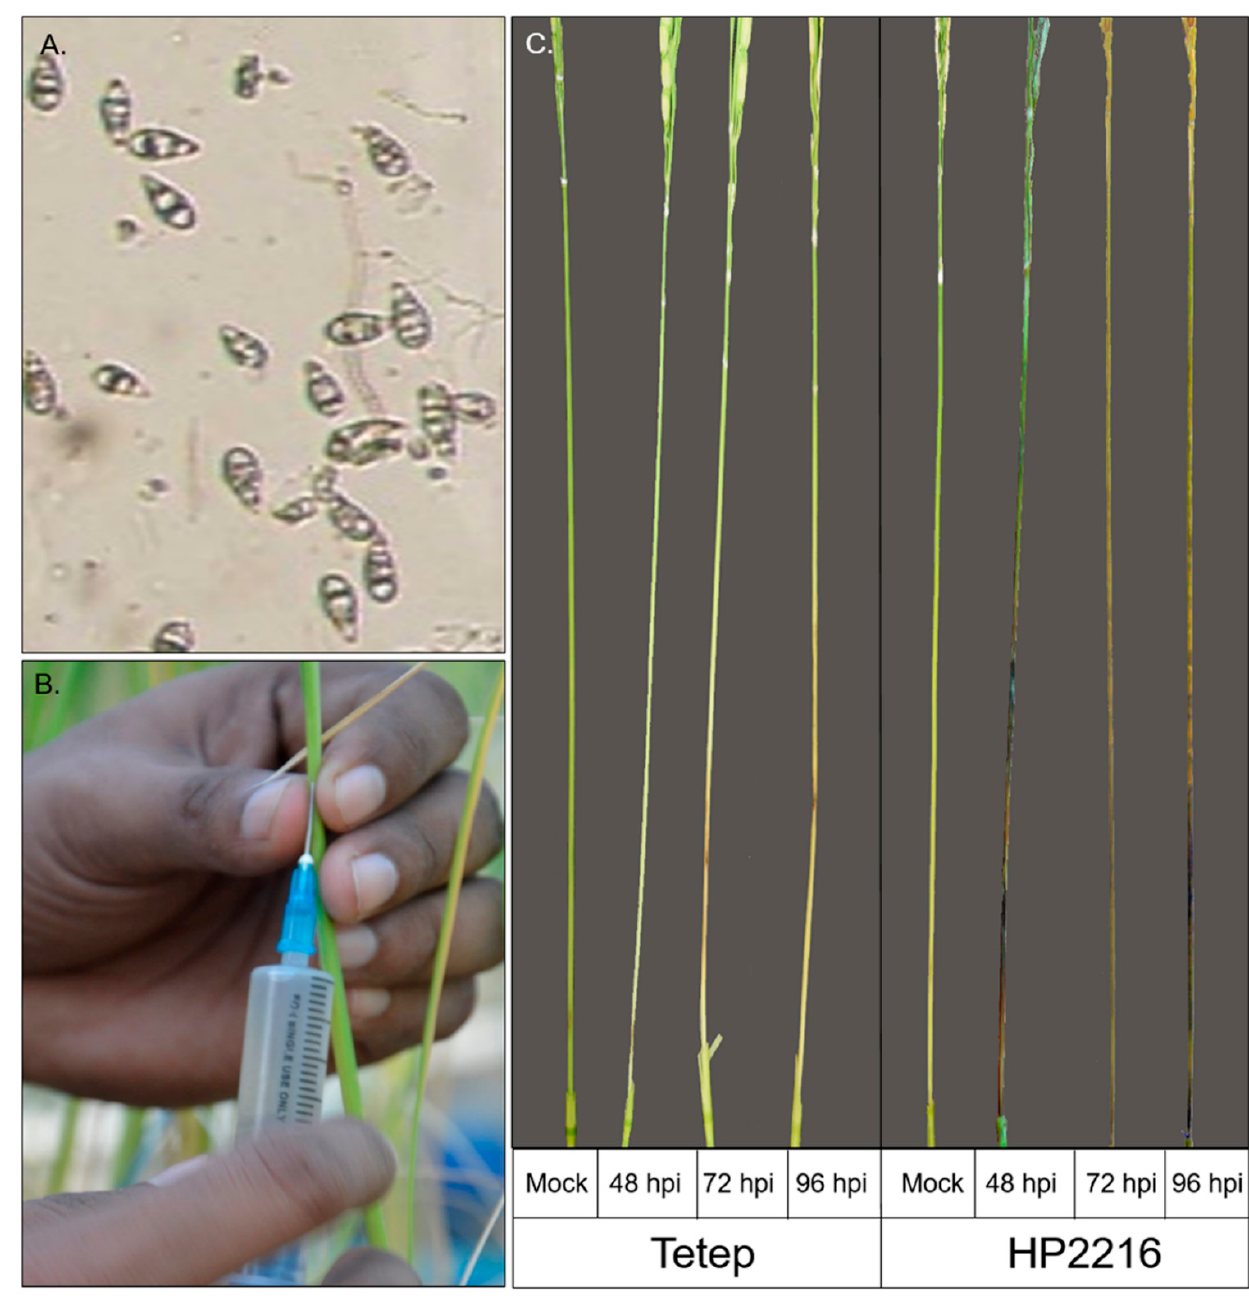
Figure 1. Inoculation of M. oryzae to rice panicles and disease phenotyping. ( A ) Suspension of M. oryzae spores, ready to infect the host. ( B ) Infection was given to the neck of rice panicle using 5 mL syringe. ( C ) Representative image of rice panicles showing the impact of pathogen on blast resistant (Tetep) and susceptible (HP2216) cultivars at different time intervals at 48 hpi, 72 hpi and 96 hpi (hpi= hour post infection) along with mock inoculated.